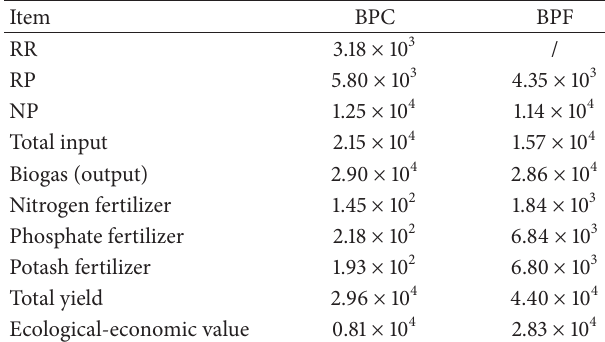
Table 3: Table of emergy monetary value